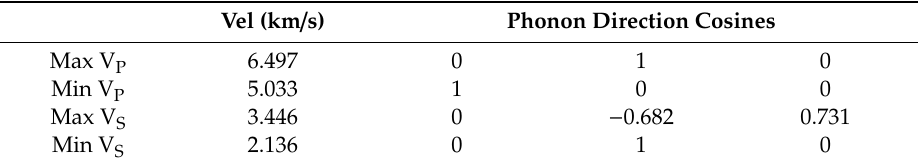
Table 2. Direction of maximum and minimum V P and V S .